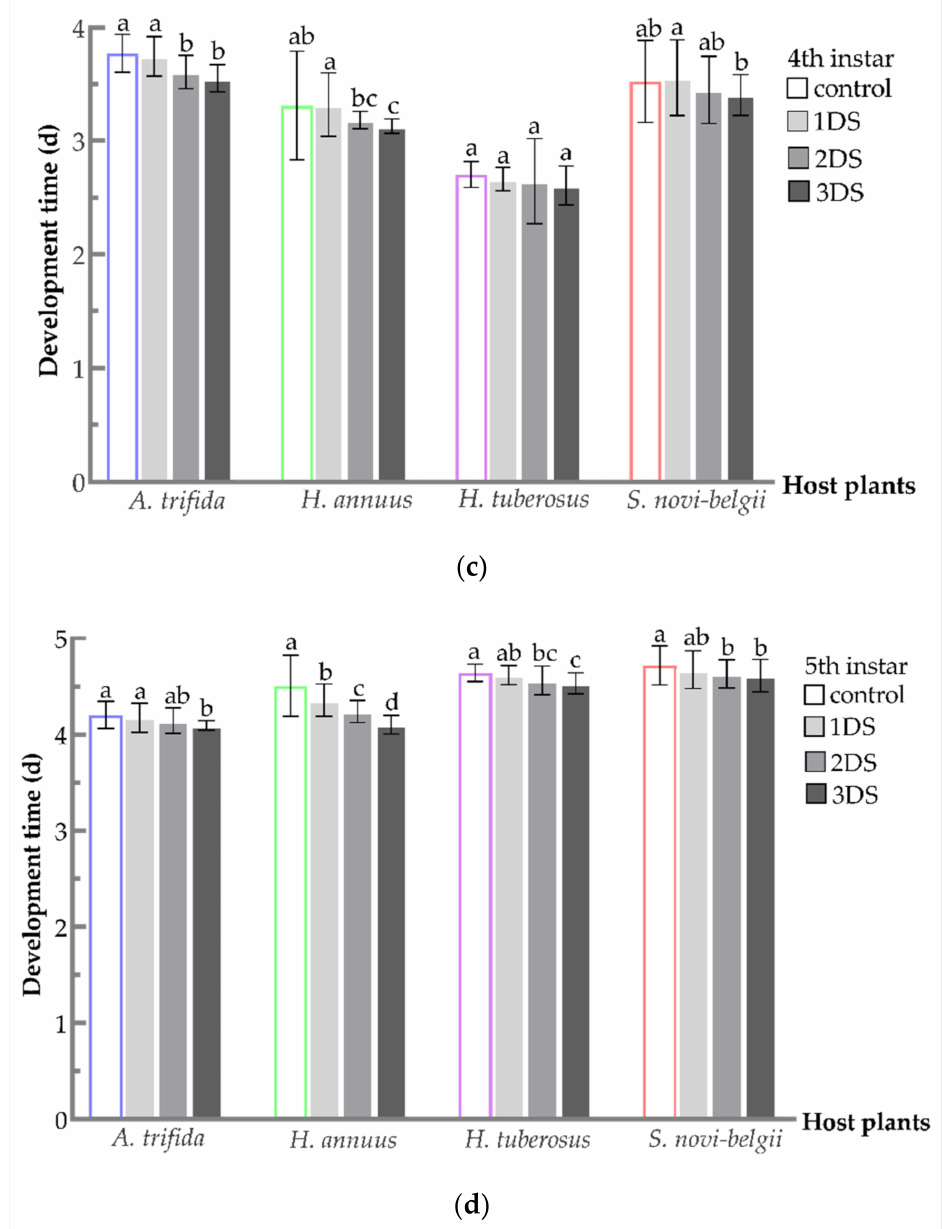
Figure 1. Development time of C. marmorata nymphs suffering from food deprivation on four host plants. ( a ) 2nd instar nymph; ( b ) 3rd instar nymph; ( c ) 4th instar nymph; and ( d ) 5th instar nymph. Control: the group offered host leaflets continuously without food deprivation; 1DS: group subjected to 1 day’s starvation; 2DS: group subjected to 2 days’ starvation; and 3DS: group subjected to 3 days’ starvation. Values are the mean ± SD. Different lowercase letters “a, ab, b, bc, c, d” in one species of host plants indicate significant differences (one-way analysis of variance followed by Duncan’s test, p <